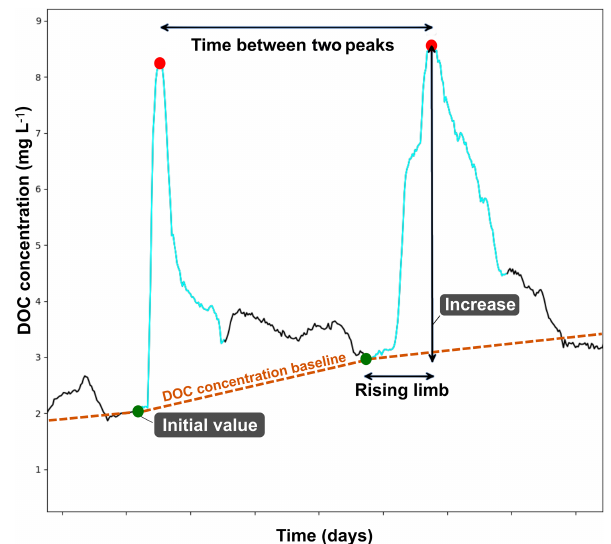
Figure 2. Characterization of DOC concentration peaks. Peak events are identified on the DOC concentration timeline in blue. Each DOC concentration peak event is defined by an initial con- centration (green points) and a maximum one (red points). DOC concentration increase is calculated by subtracting the initial from the maximum concentration. The time between 2 maximum DOC concentrations corresponds to the duration (seconds) separating two events and is used as an explanatory variable. The DOC concen- tration baseline (orange dotted line) corresponds to the time series defined by all the initial values of each DOC concentration